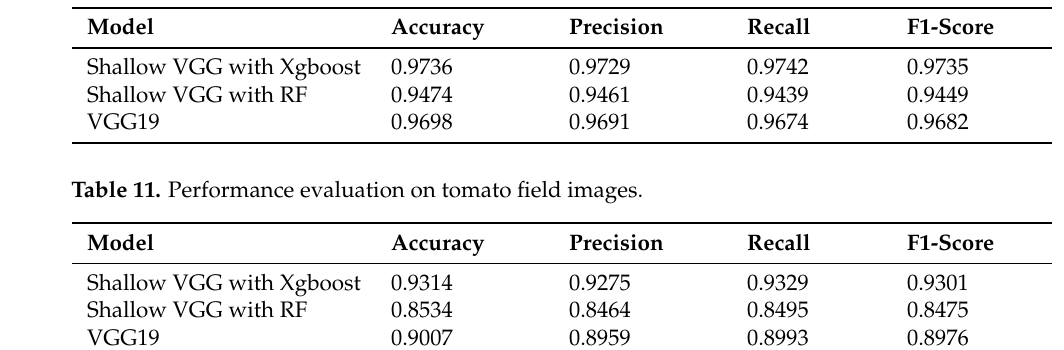
Table 10. Performance evaluation on potato field images.